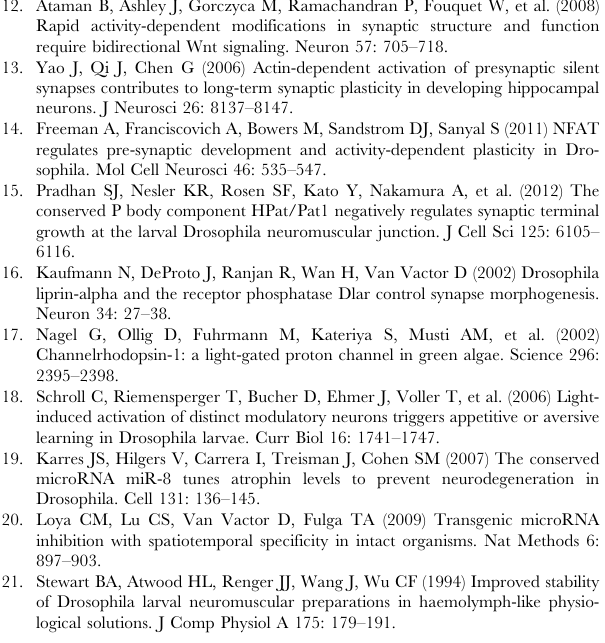
Table S5 Predicted targets of all activity-regulated miRNAs. A list of the 33 predicted mRNA targets for co- regulation by miRs-8, -289, and